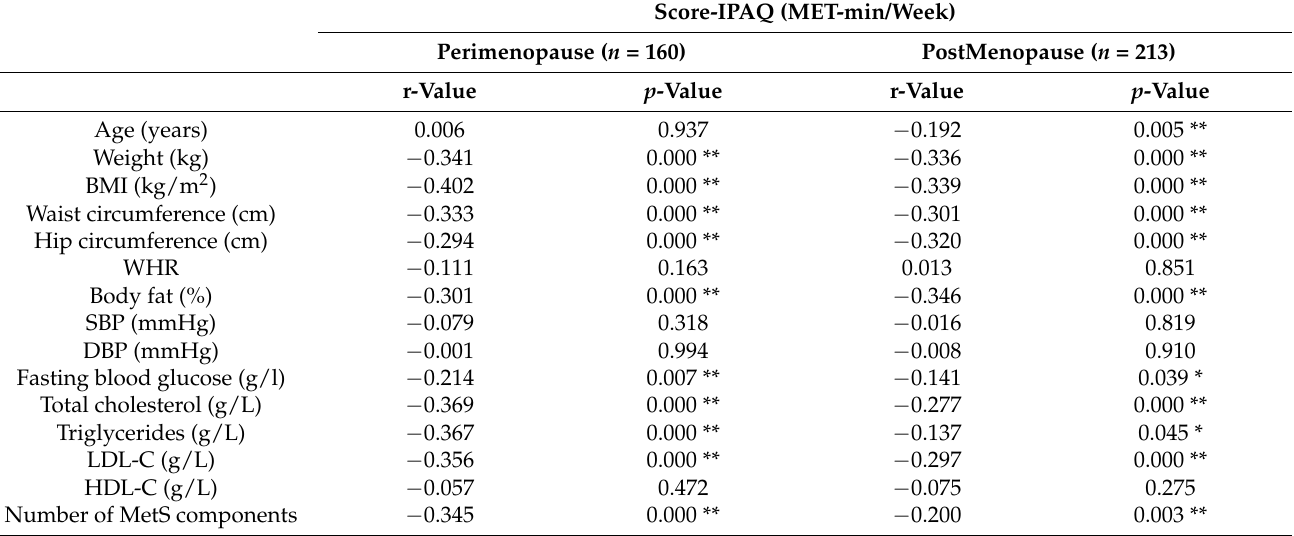
Table 4. Correlations between anthropometric and biological study parameters, and physical activity (IPAQ) in peri- and postmenopausal